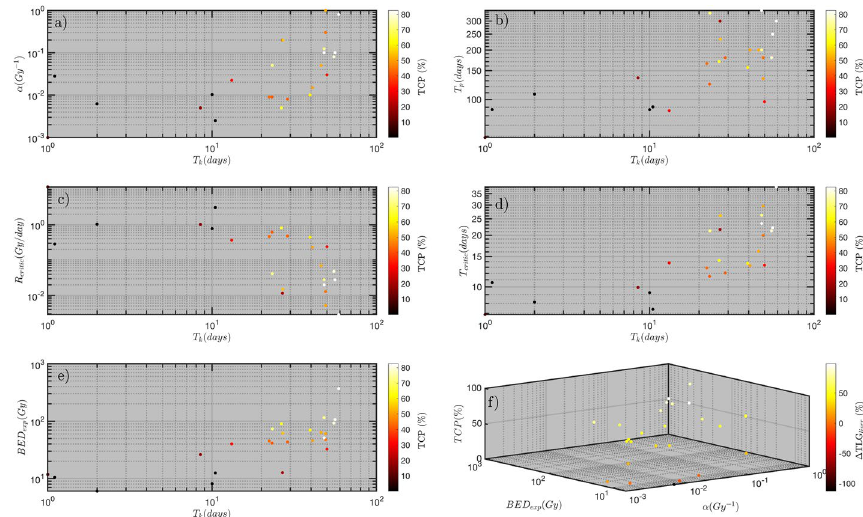
Fig. 6 a – e The relationship between the clinically estimated radiobiological parameters and TCP. f 4D scatter plot demonstrating the relationship between the biological effective dose ( BED exp ), α parameter, TCP, and the total liver lesion glycolysis (cid:31) TLG